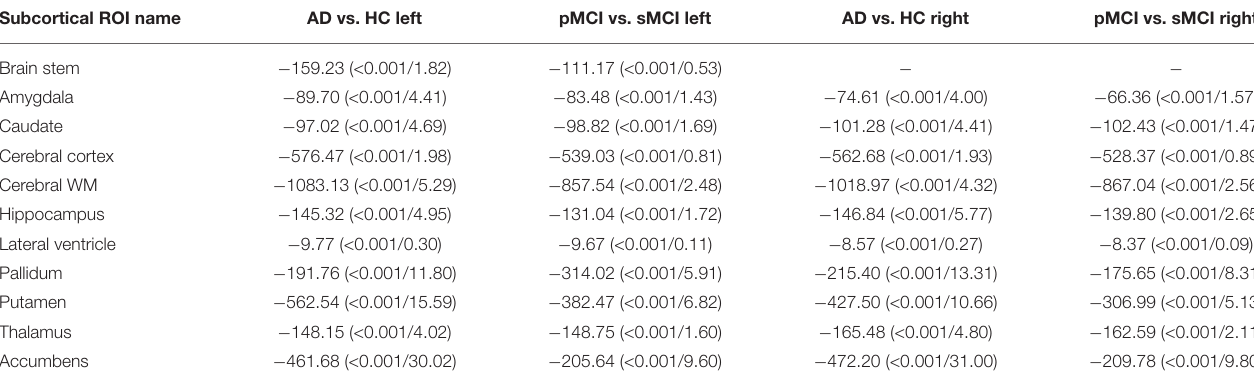
TABLE 5 | Welch’s t -test statistic ( p -value/Cohen’s d ) values for different subcortical ROIs from the Harvard-Oxford